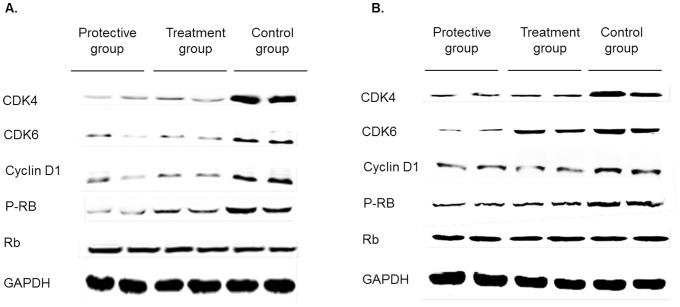
The expression of cell cycle related proteins in vivo.Cyclin D1, CDK4, CDK6 and pRb protein expression were down-regulated in the xenograft tumors of 5-8F(A) and CNE2(B) in I3C preventive and I3C treatment groups compared to the control group. The data are presented as the mean± SEM.